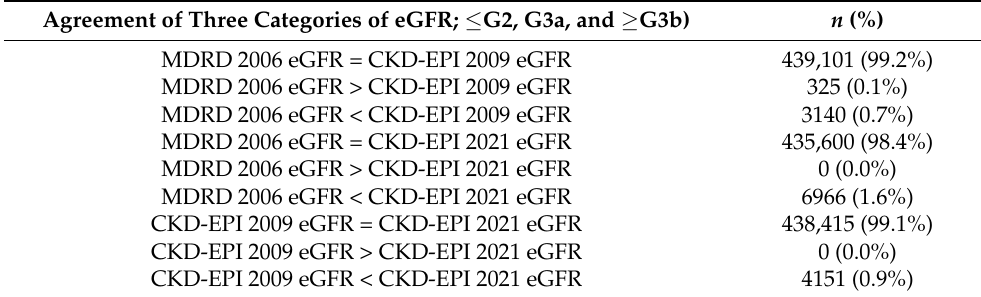
Table 2. Overall agreement of qualitative estimated glomerular filtration rates (eGFR) grades among three equations for estimated glomerular filtration